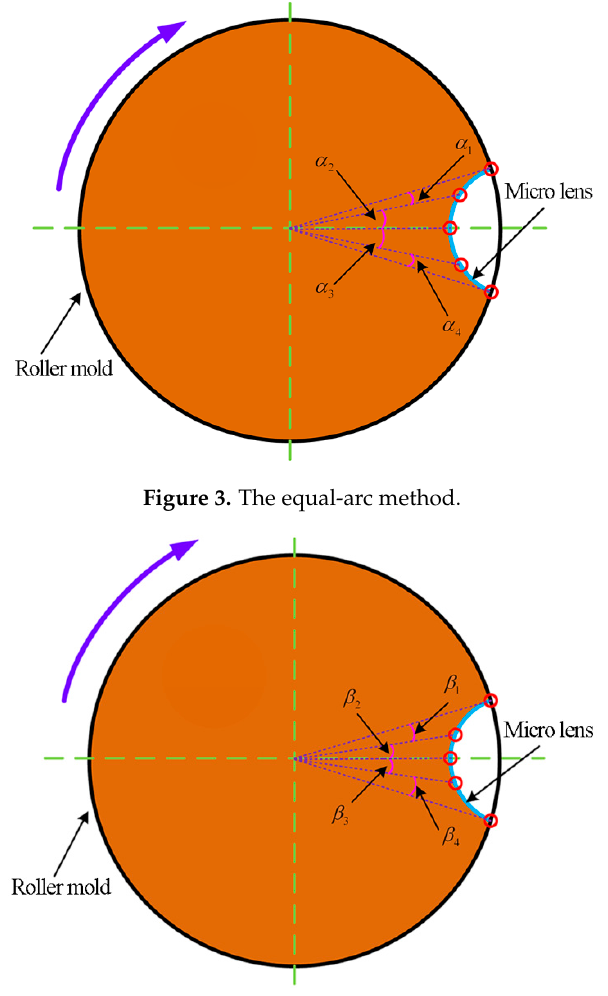
Figure 4. The equal-angle method.